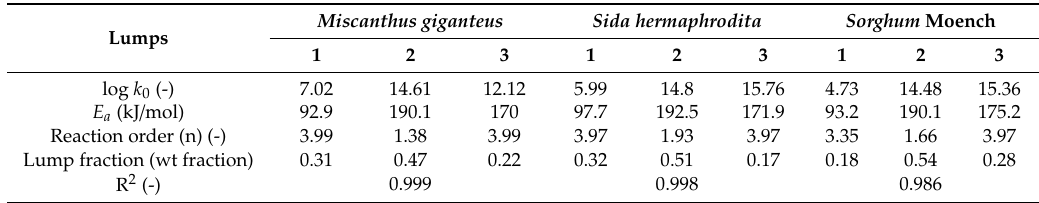
Table 3. Model parameters of energy crop